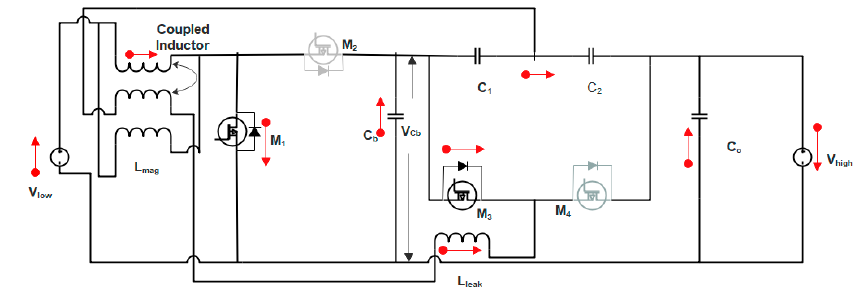
Figure 6. Equivalent circuit for mode IV.